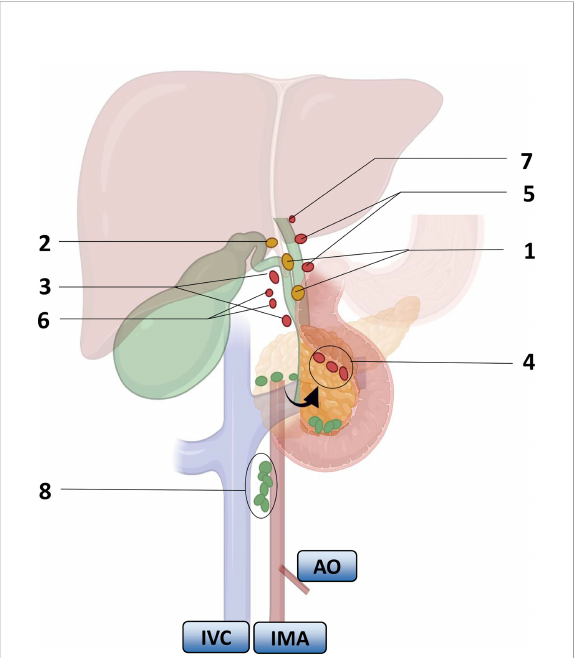
FIGURE 1 Lymph node substations and return routes for gallbladder cancer metastasis. Arrows indicate turning the pancreas head over. Numbers represent lymph nodes: 1. peri-biliary lymph nodes, 2. bile duct lymph nodes, 3. peri-portal lymph nodes, 4. lymph nodes behind the pancreaticoduodenum and above the head of the pancreas, 5. peri-hepatic artery lymph nodes, 6. peri-hepatic right artery lymph nodes, 7. hilar lymph nodes, 8. interaortocaval nodes. IVC: inferior vena cava, IMA: inferior mesenteric artery, AO: aorta. Color: First-order lymph nodes (yellow), second- order nodes (red), distal nodes